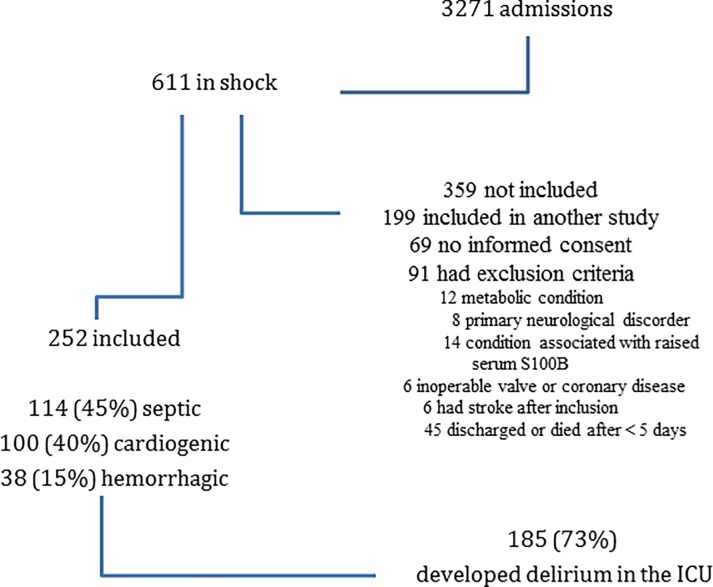
Patient inclusion and outcomes.